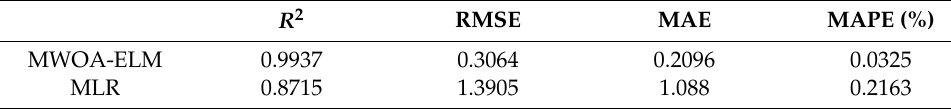
Figure 21. Regression analysis result of the MRL model. Table 9. Evaluation indicators for the MWO-ELM and MRL model.